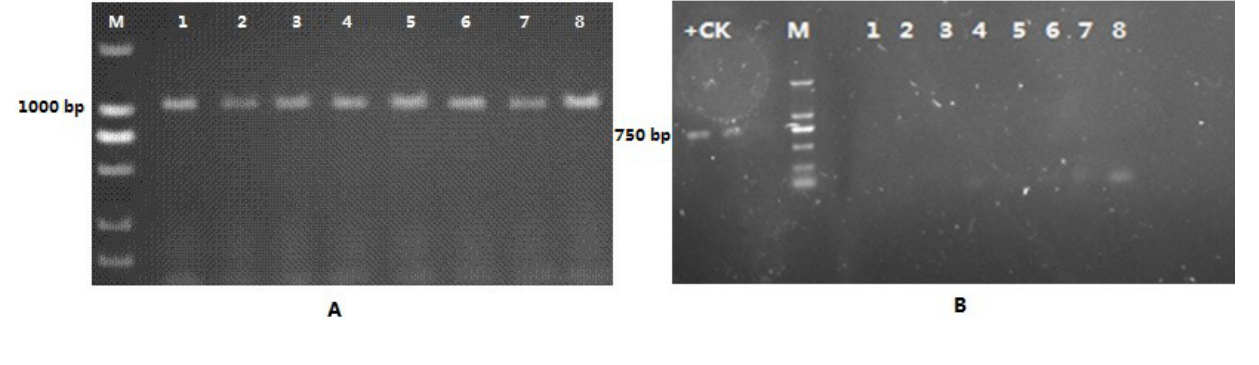
+CK, positive control; M, DNA marker (D2000 DNA marker); 1–8, samples. ( A ) PCR amplification of bacterial 16S rDNA as a control. All samples showed amplification of specific bands. ( B ) PCR amplification of the npt II gene. No amplification was found in the